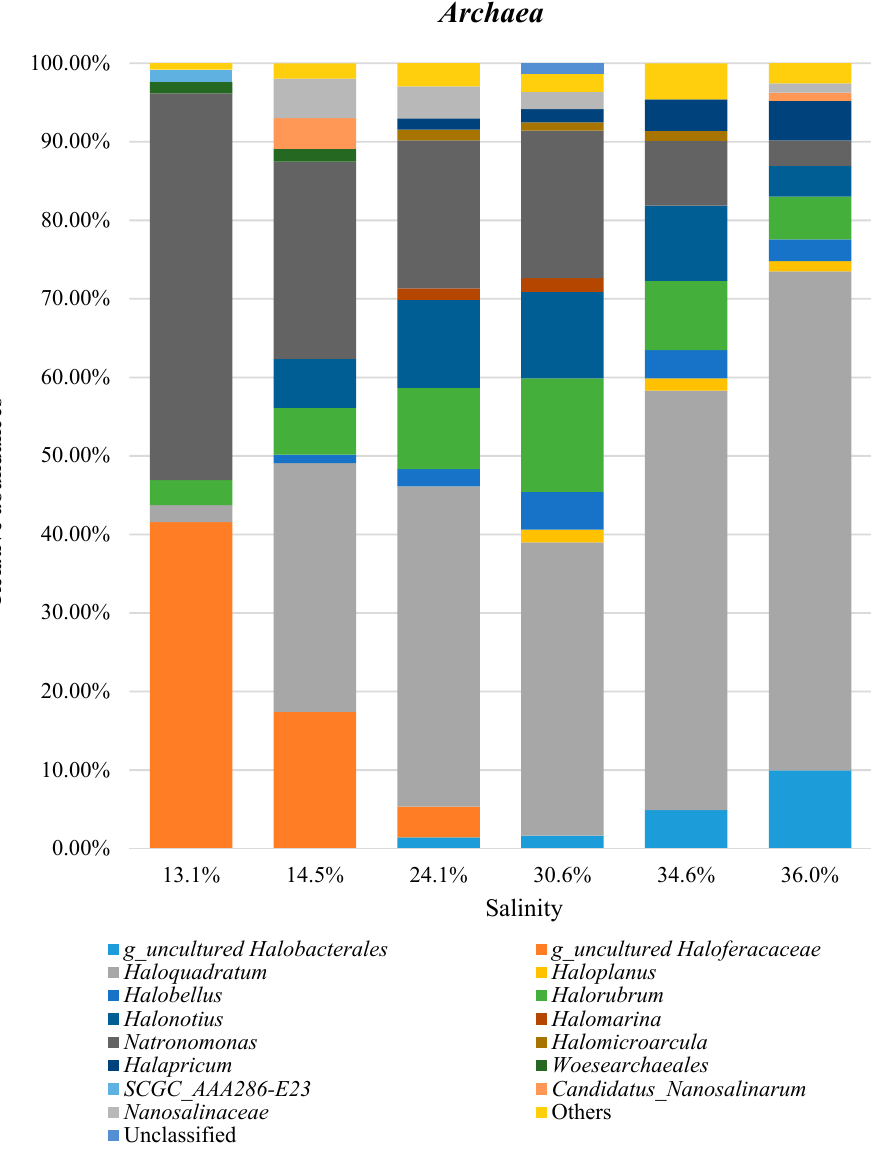
Figure 5. Bar charts of Bacteria and Archaea genera identified at different salinities in MdS saltern. Groups with relative abundances < 1.0% were joined as ‘Others’. Salinity is reported as salt percentage ( w / v ). ASVs which could not be resolved at the genus level were reported with the notation g_uncultured followed by the name of the closest known parental rank. A list of the identified genera and their relative abundances is reported in Table S5.